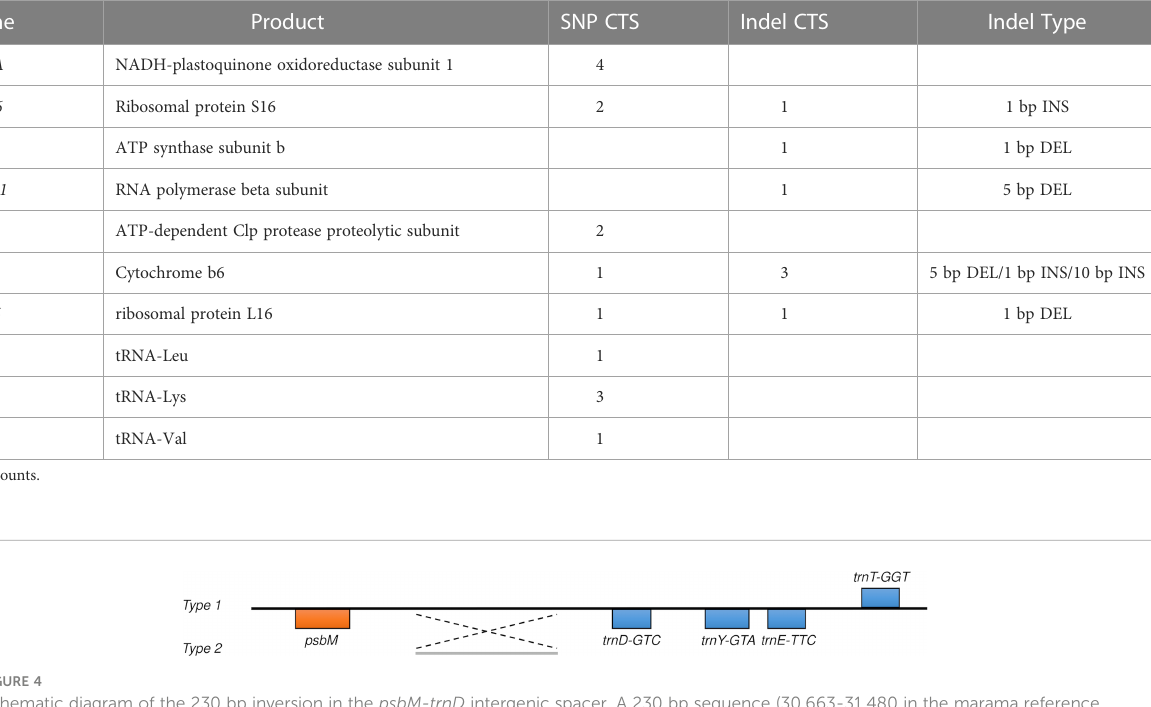
FIGURE 4 Schematic diagram of the 230 bp inversion in the psbM-trnD intergenic spacer. A 230 bp sequence (30,663-31,480 in the marama reference cpDNA) is reversed in all Type 2 individuals. However, all Type 1 plants are consistent with the reference genome in this area. The surrounding region contains a set of closely located tRNA